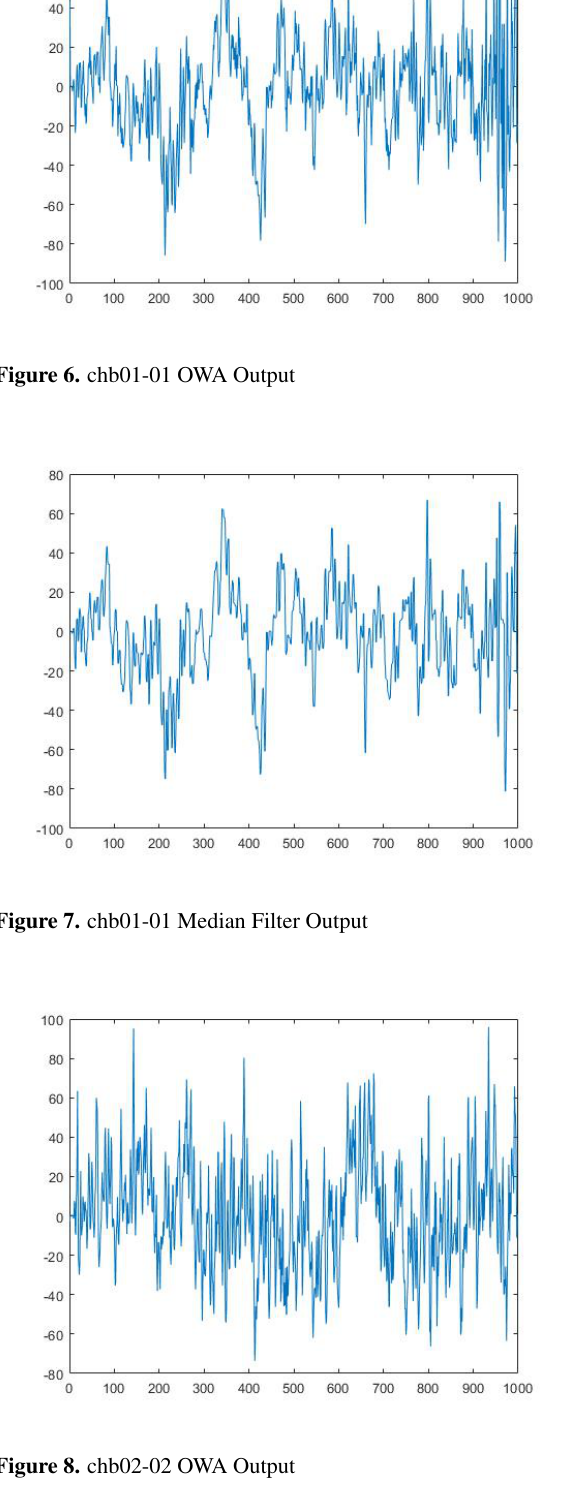
Figure 11. chb02-03 Median Filter